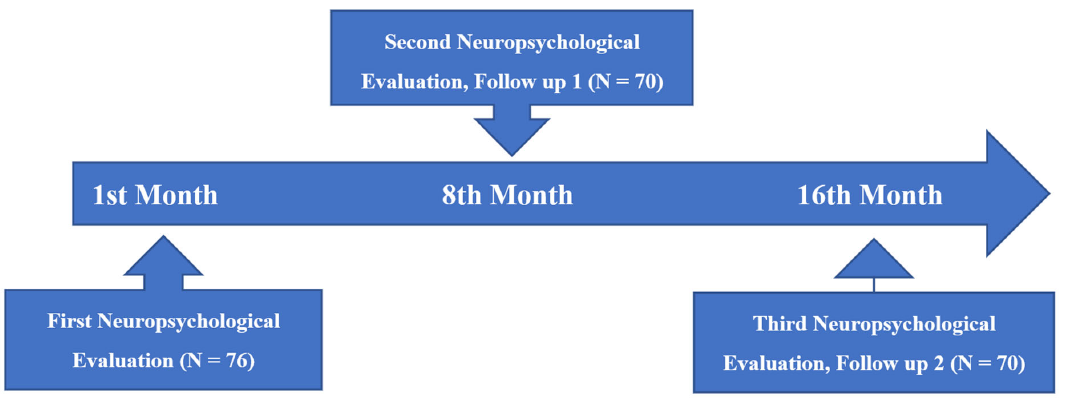
Figure 1. Timeline of the study